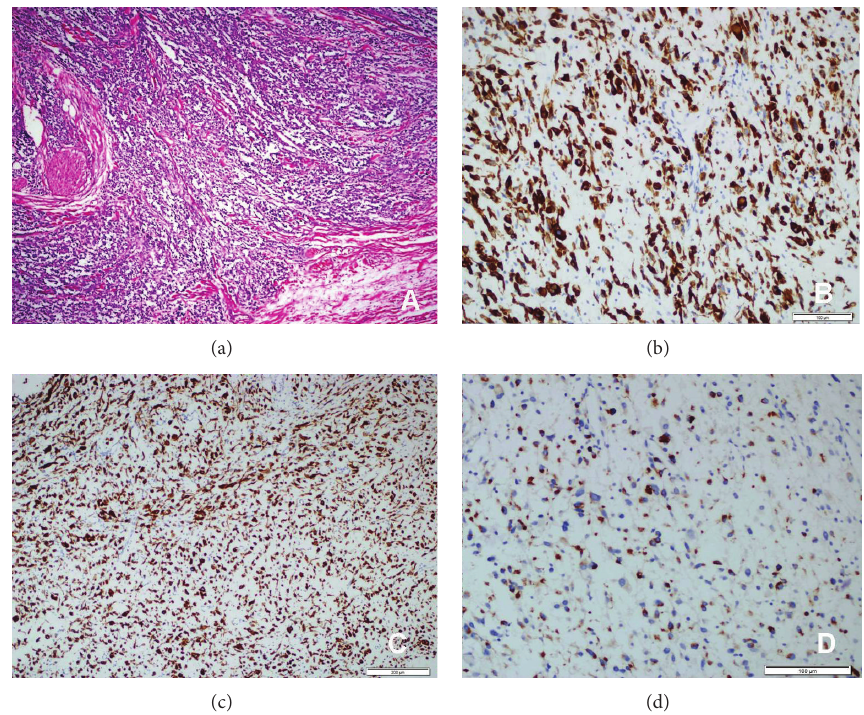
Figure 1: (a) Rhabdomyosarcoma (HEX100); (b) tumor cells are strong positive ones with myo-D1 (myo-D1X200); (c) there was also strong positivity with vimentin (vimentin X 100); (d) there was focal positivity for desmin (desmin X200).